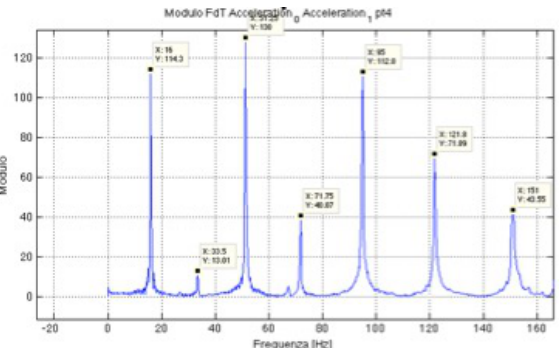
Figure 2. A typical FRF plot (acceleration amplitude vs.